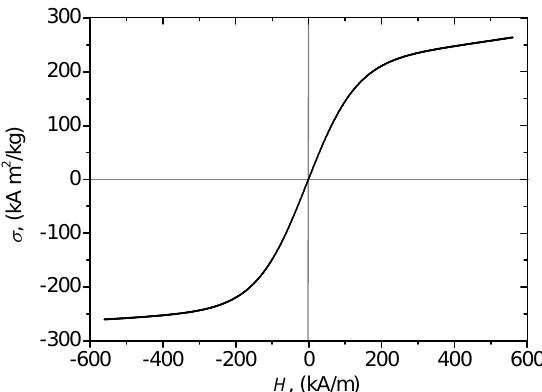
Figure 1. Magnetization curve of carbonyl iron (CI) microparticles. The measurements were performed under sine waveform driving field conditions by means of a laboratory made ac induction hysteresis graph described in Reference [20].